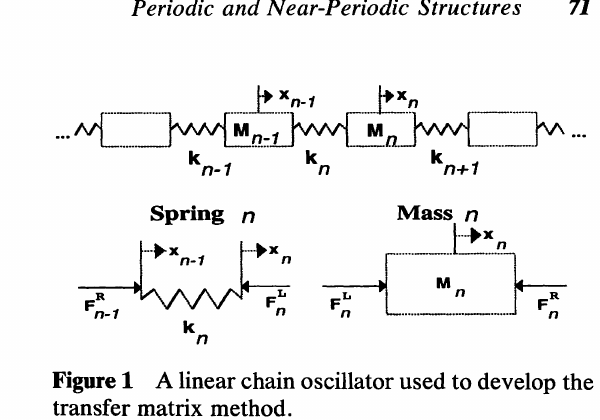
Figure 1 A linear chain oscillator used to develop the transfer matrix